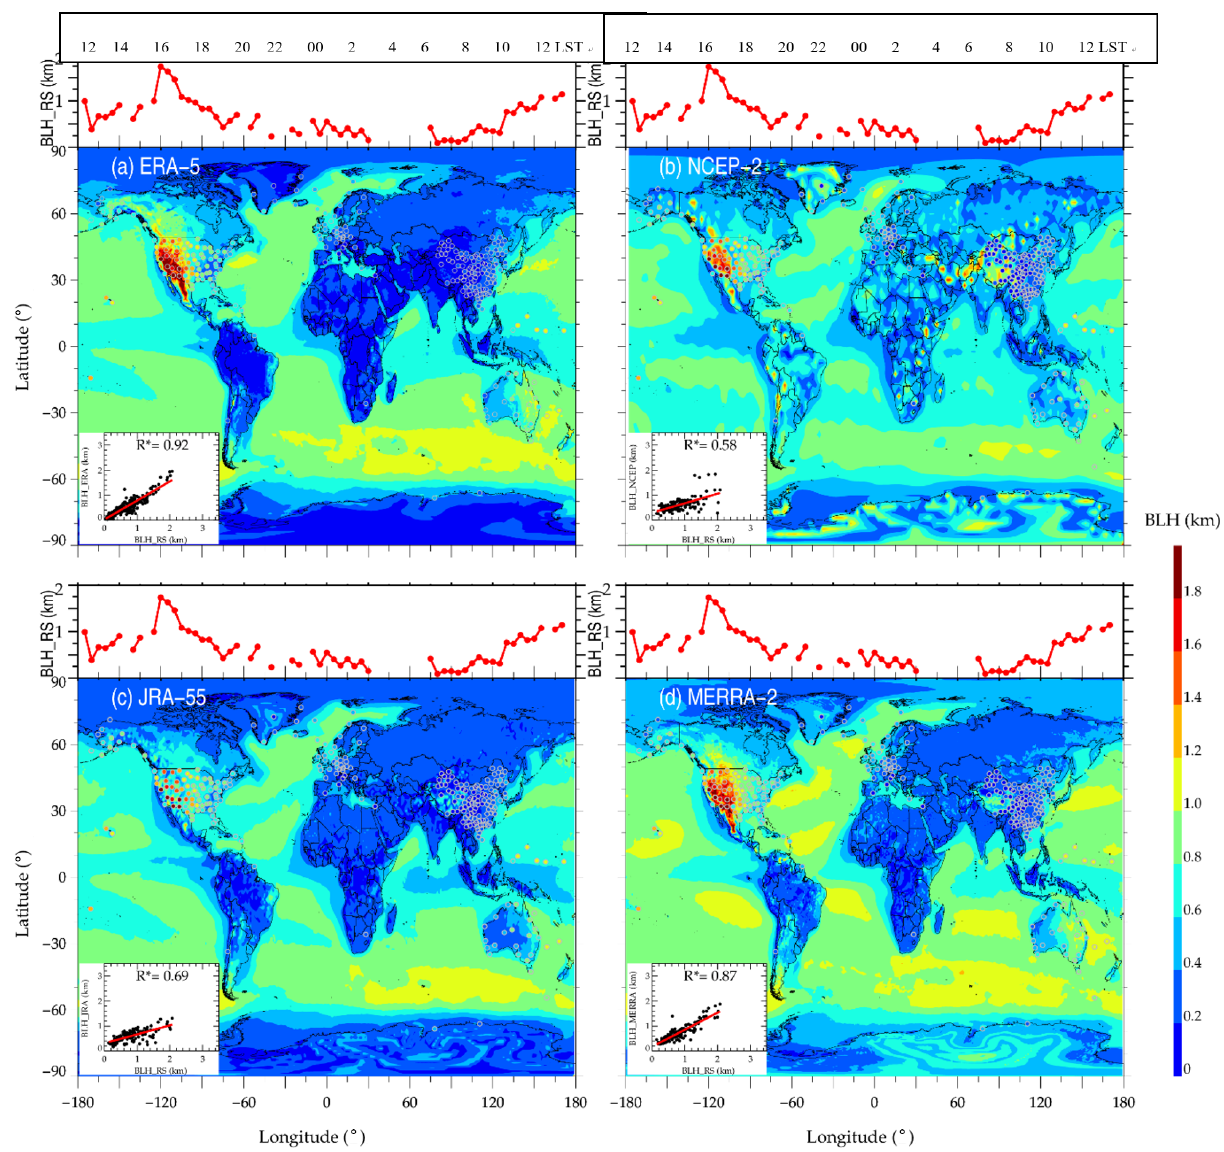
Figure 2. The mean BLH estimated from ERA5 (a) , NCEP-2 (b) , JRA-55 (c) , and MERRA-2 (d) reanalysis data at 00:00UTC during the years 2012–2019. The dots with gray marginal lines in each map denote the mean BLH derived by sondes at 00:00UTC, and the dotted red lines present the mean BLH derived by radiosonde on a grid with 5 ◦ longitude. Stations with less than 10 profiles are not included in the analysis. The 2D scatter plot in the bottom left corner of each panel illustrates the correlations between reanalysis-derived and sonde-derived BLHs at 00:00UTC, for which the asterisk (*) superscripts indicate that the correlation coefficients are statistically significant ( p< 0 . 05), and the red lines denote the least-squares regression